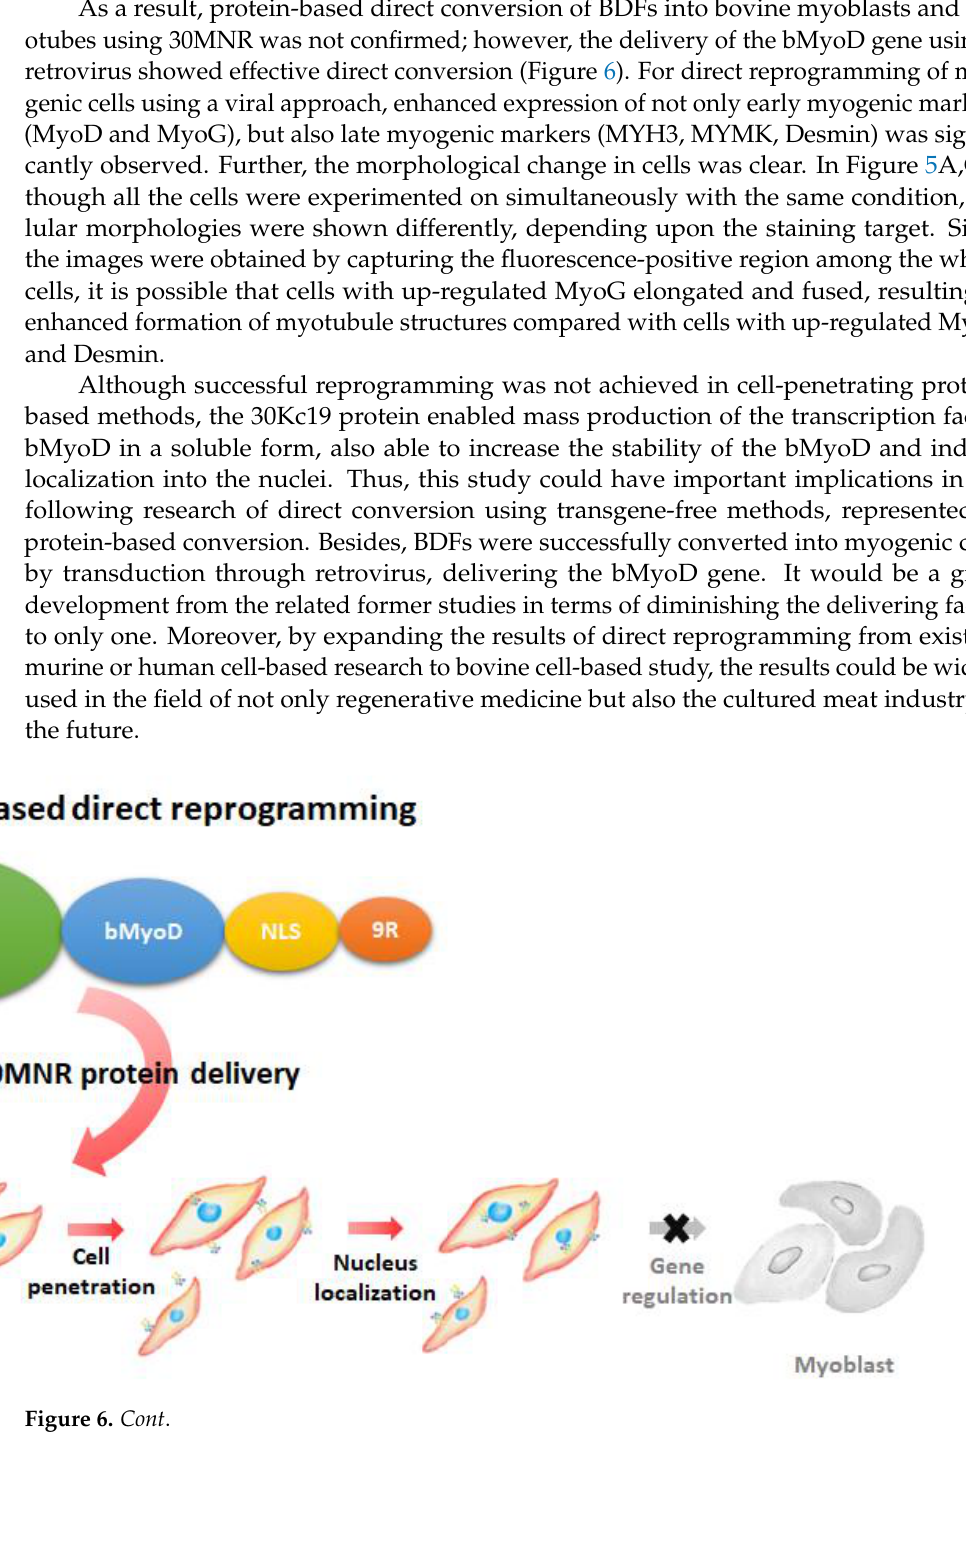
Figure 6. Schematic illustration of direct reprogramming of BDFs into myoblasts or myotubes using viral-based bMyoD delivery. ( A ) Inefficient method using protein-based approach and ( B ) efficient method using viral-based approach. Author Contributions: S.H.L. and S.H. collected data and evidence. B.S., K.S.L. and H.H.P. con- ceived and designed the study. B.S. and H.H.P. wrote the manuscript. B.S. and S.H.L. drew the figures. B.S., M.K., J.J., K.S.L. and H.H.P. directed and validated the data analysis. All authors have read and agreed to the published version of the manuscript.